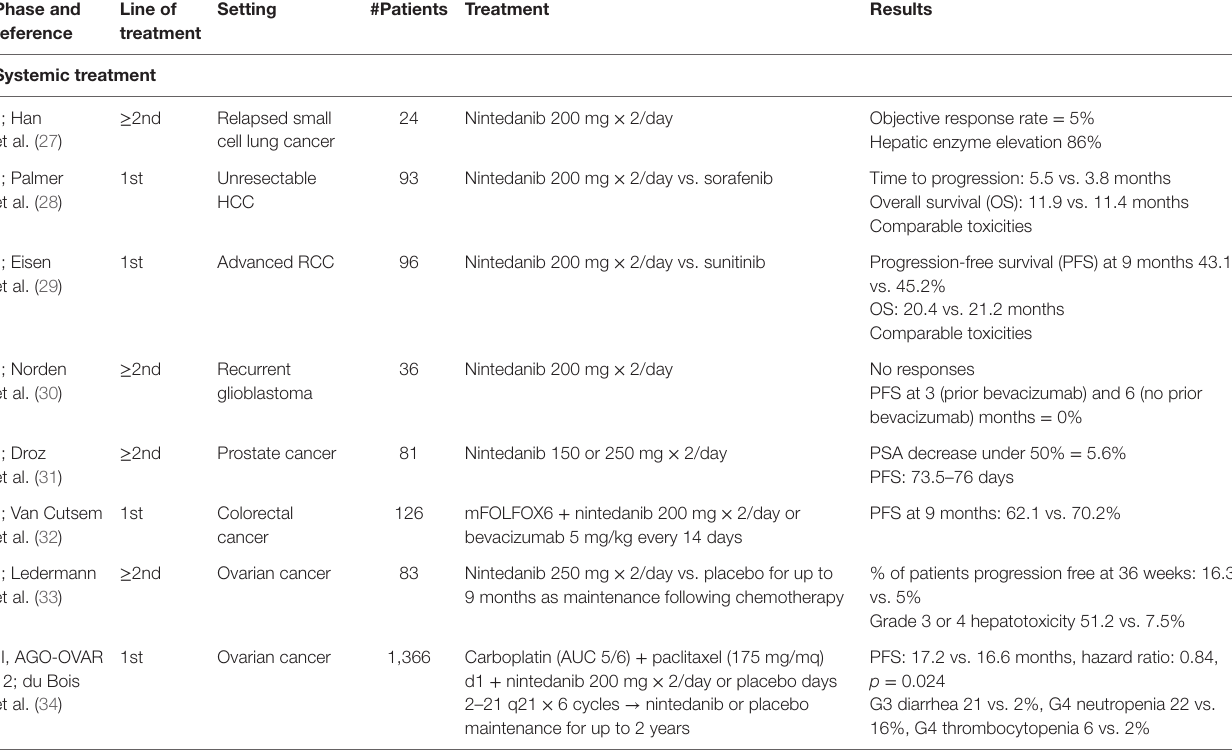
TABLe 2 | Studies with nintedanib in other